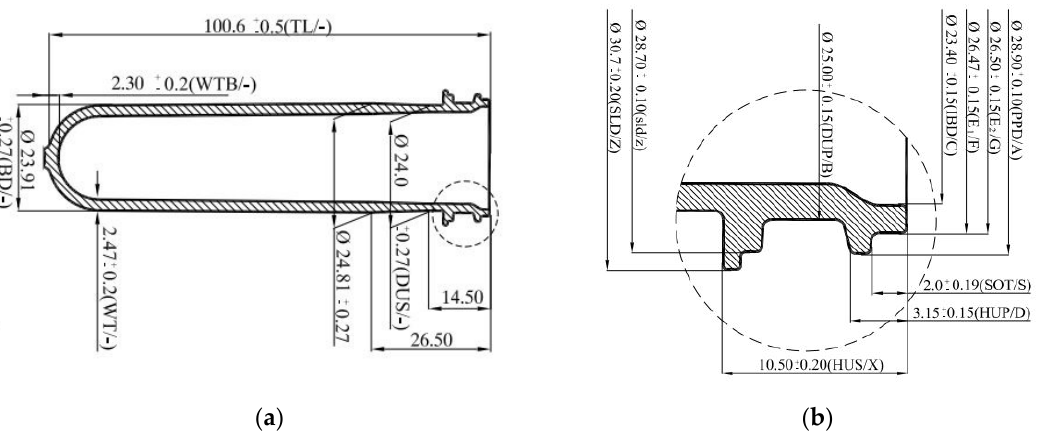
Figure 2. ( a ) Standard dimensions of the 28 g preform; ( b ) minor details of the magnified region.